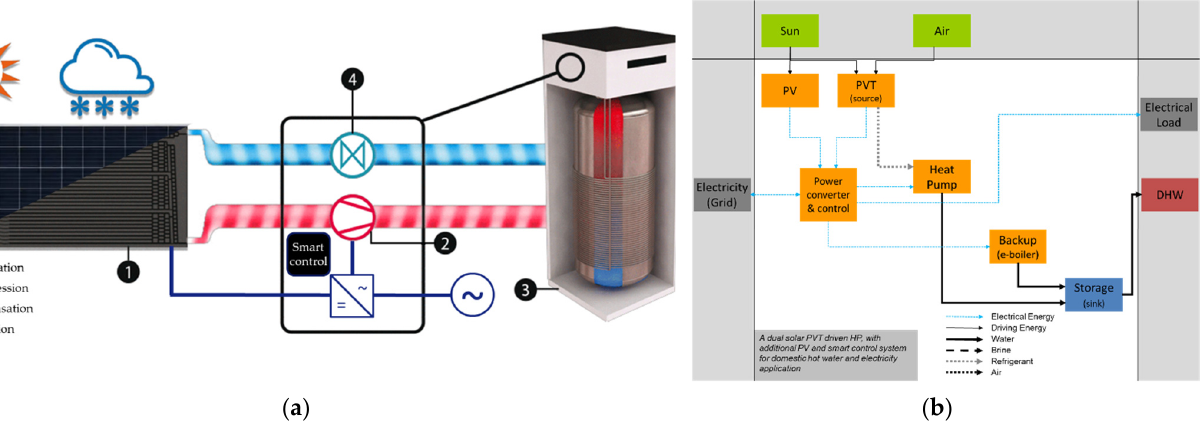
Figure 1. A representation of the PVT dually coupled HP technology: ( a ) Physical scheme of main system elements; ( b ) Solution square view following IEA procedure [17,18].